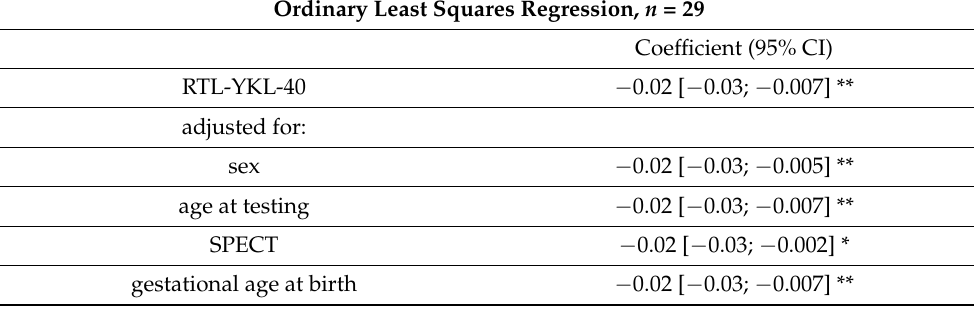
Figure 2. Correlation between relative telomere length (RTL) and YKL-40 at 10 years of age in 29 children born preterm with a history of BPD ( p < 0.01). The darker circles represent good ventilation to perfusion ratios in more than 70% of the total lung volume ( n = 15), and the brighter circles ( n = 10) represent the group with more abnormalities (<70%). Table 1. Correlation between the relative telomere length (RTL) and YKL-40 at ten years of age in children born preterm with a history of